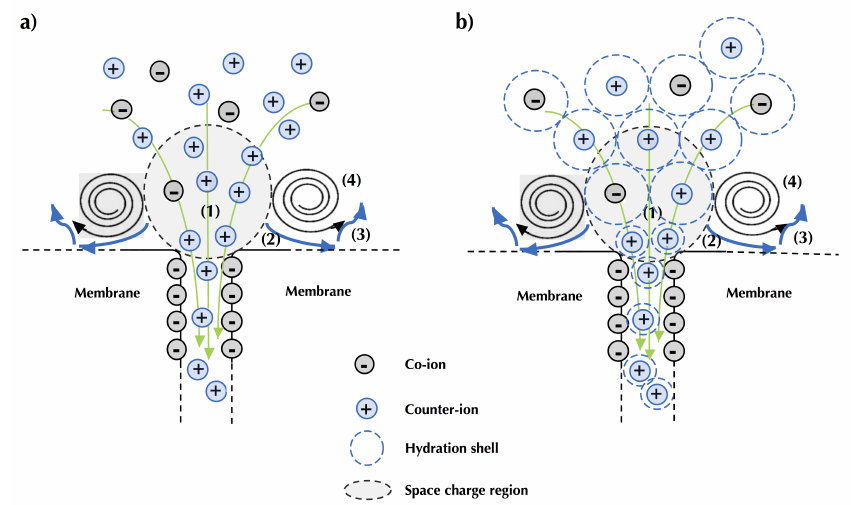
Figure 10. Occurrence of electroconvective vortices at membrane interface due to electroosmosis of the second kind ( a ) as currently accepted (adapted from Nikonenko et al. [21]) and ( b ) hypothetic, taking into account the ion hydration